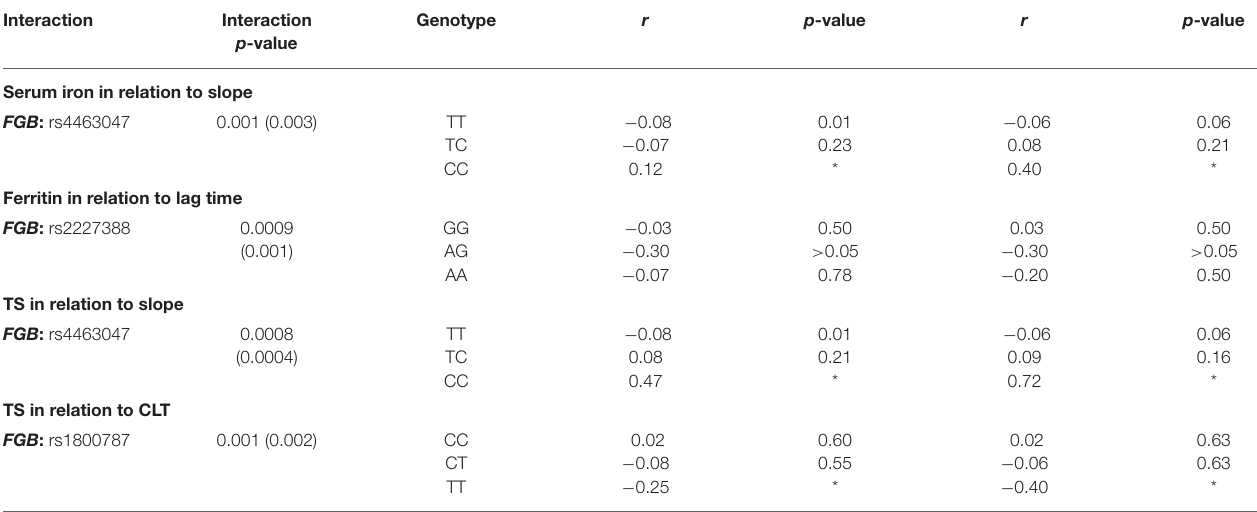
TABLE 4 | FGB , gene polymorphisms’ interactions with biomarkers of iron status in relation to clot properties. Interaction Interaction Genotype r p -value r p -value p -value Serum iron in relation to